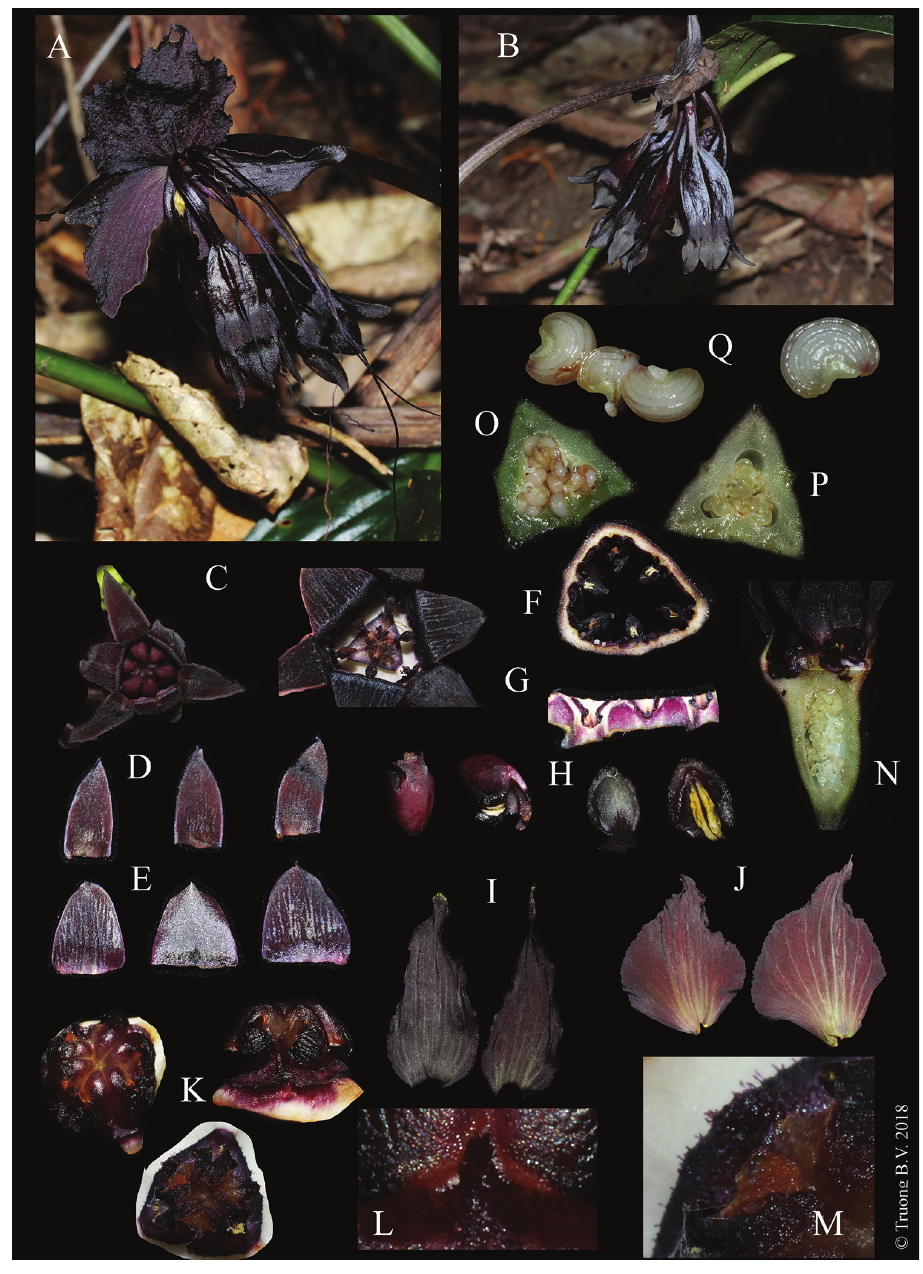
Figure 3. Tacca khanhhoaensis V.S. Dang & Vuong. A Inflorescence B Fruits C Flowers, top view showing perianth lobes, stamens and stigma D Outer perianth lobes E Inner perianth lobes F Inner surface of peri- anth tube G Anther and connective H Longitudinal section of Anther with a pair of theca I Outer involucral bracts J Inner involucral bracts K Stigmas L Finely pubescent hairs at apex of stigma lobes M Black hairs on style N Longitudinal section of flower O Transverse section of fruit P Transverse section of ovary Q